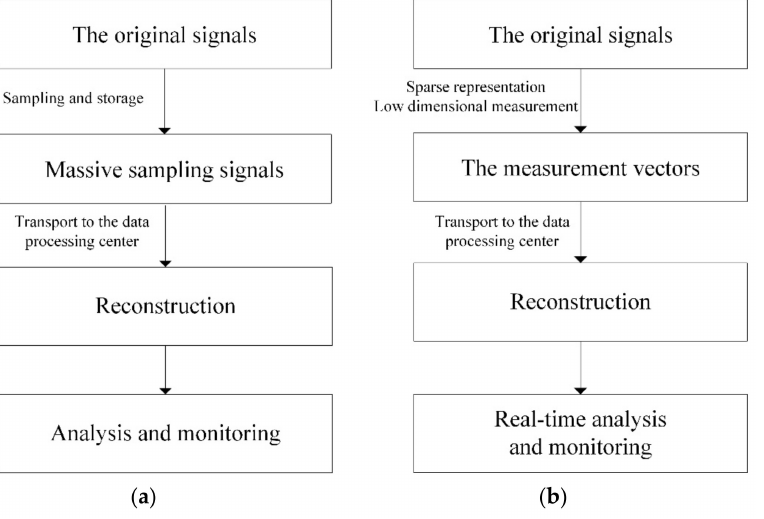
Figure 1. Comparison of different monitoring schemes for vehicle. ( a ) The conventional monitoring scheme; ( b ) Real-time vehicle health monitoring using